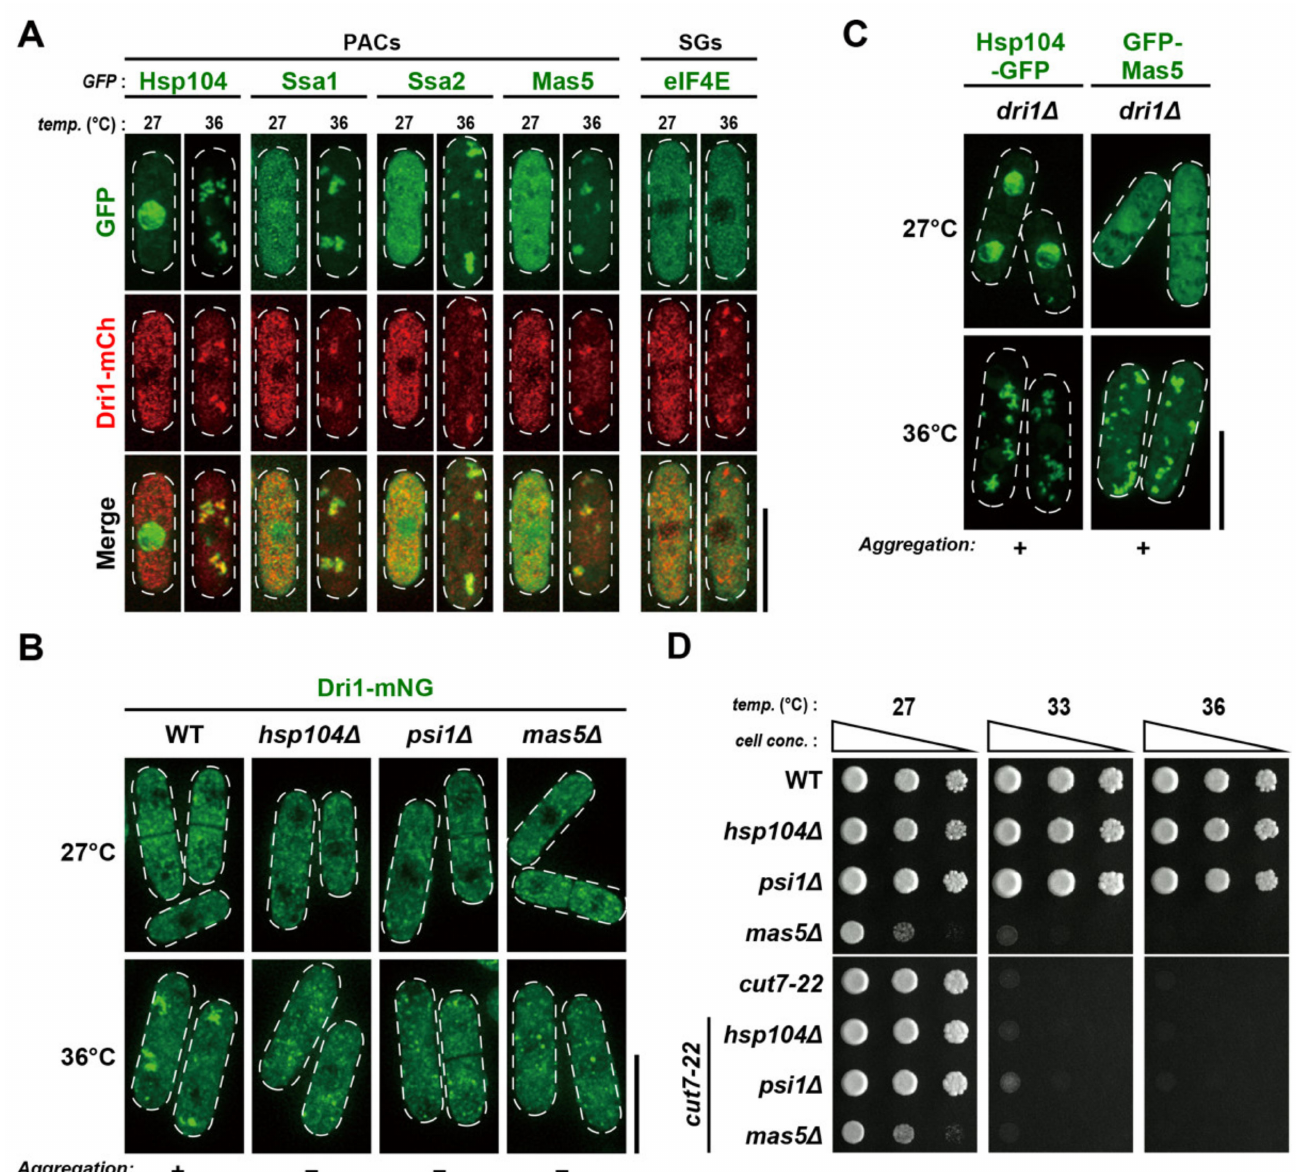
Figure 4. Dri1 is present at protein aggregate centers upon mild temperature shift-up. ( A ) A portion of the Dri1 protein co-localizes with the components of PACs by temperature shift-up. Cells containing Dri1-mCherry and different GFP-tagged chaperones (Hsp104, Ssa1, Ssa2 and Mas5) were grown at 27 ◦ C and then shifted to 36 ◦ C for 2 h. SGs are not formed under this condition, as monitored in cells co-expressing Dri1-mCherry and eIF4E-GFP (an SG marker) after incubation at 36 ◦ C for 2 h. ( B ) Several chaperones, such as Hsp104, Psi1 and Mas5, are required for the Dri1 assembly during mild temperature shift-up. Wild-type, hsp104 ∆ , psi1 ∆ and mas5 ∆ strains expressing Dri1-mNeonGreen were grown at 27 ◦ C and then shifted to 36 ◦ C for 2 h. ( C ) Dri1 is dispensable for the assembly of PACs. The dri1 ∆ strain expressing Hsp104-GFP or GFP-Mas5 was grown at 27 ◦ C and then was shifted to 36 ◦ C for 2 h. ( D ) Spot test. Indicated strains were serially (10-fold) diluted, spotted onto rich YE5S plates and incubated at various temperatures for 2–3 d. The cell peripheries are indicated with dotted lines. Scale bars, 10 µ